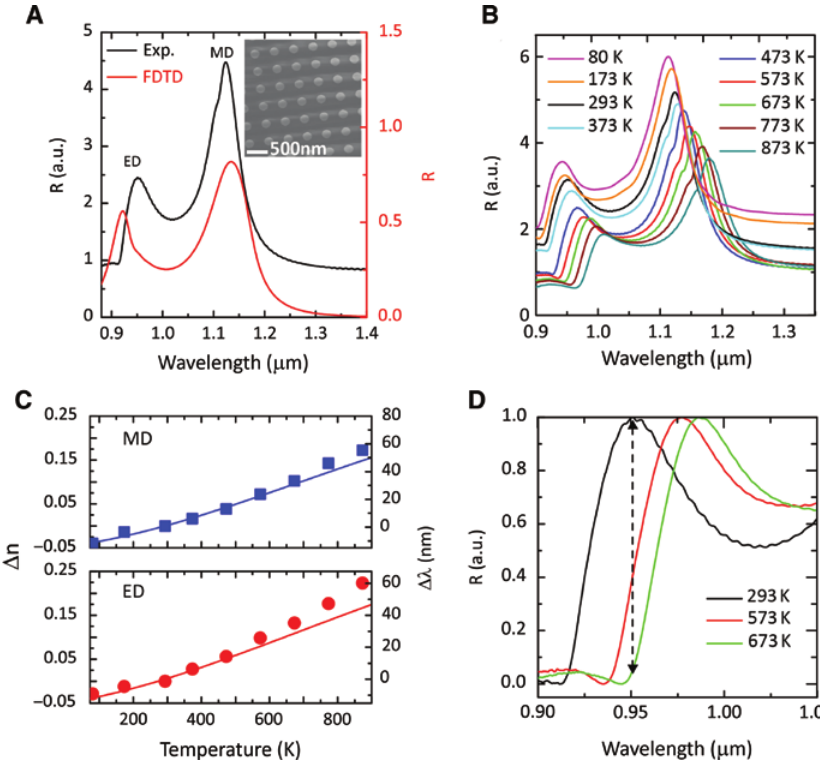
Figure 4: Thermally reconfigurable Si metasurfaces. (A) RT NIR reflection spectra of a Si metasurface disk array with disk diameter and height of d = 290 nm and h = 280 nm, respectively, and periodicity a = 590 nm on a SiO2 substrate. Experimentally measured (black) and FDTD (red) spectra are in good match showing the fundamental MD and ED modes. The inset presents an SEM image of the metasurface. (B) Temperature-dependent spectra exhibiting continuously red-shifted MD and ED resonances with increasing temperature. The spectra are vertically shifted along the y-axis for visibility. (C) Thermally induced index and wavelength shifts of MD and ED modes. (D) Thermally reconfigurable metafilter demonstration, exhibiting 4 dB and 13 dB amplitude modulation when a temperature gradient of Δ T = 280 K and Δ T = 380 K is applied,